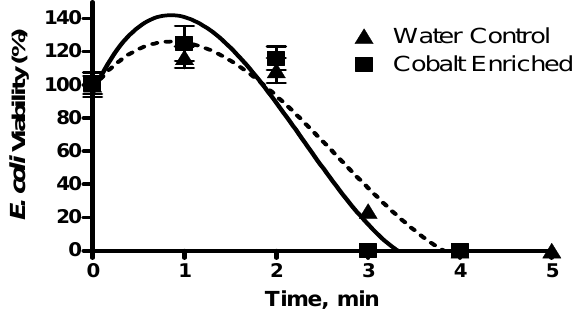
Figure 2: Effect of cobalt ions on microwave disinfection of E. coli. Illustrates the effect that cobalt ions (solid line) have on the deactivation of E. coli (n = 10) during microwave heating compared to a distilled water control (dotted line).